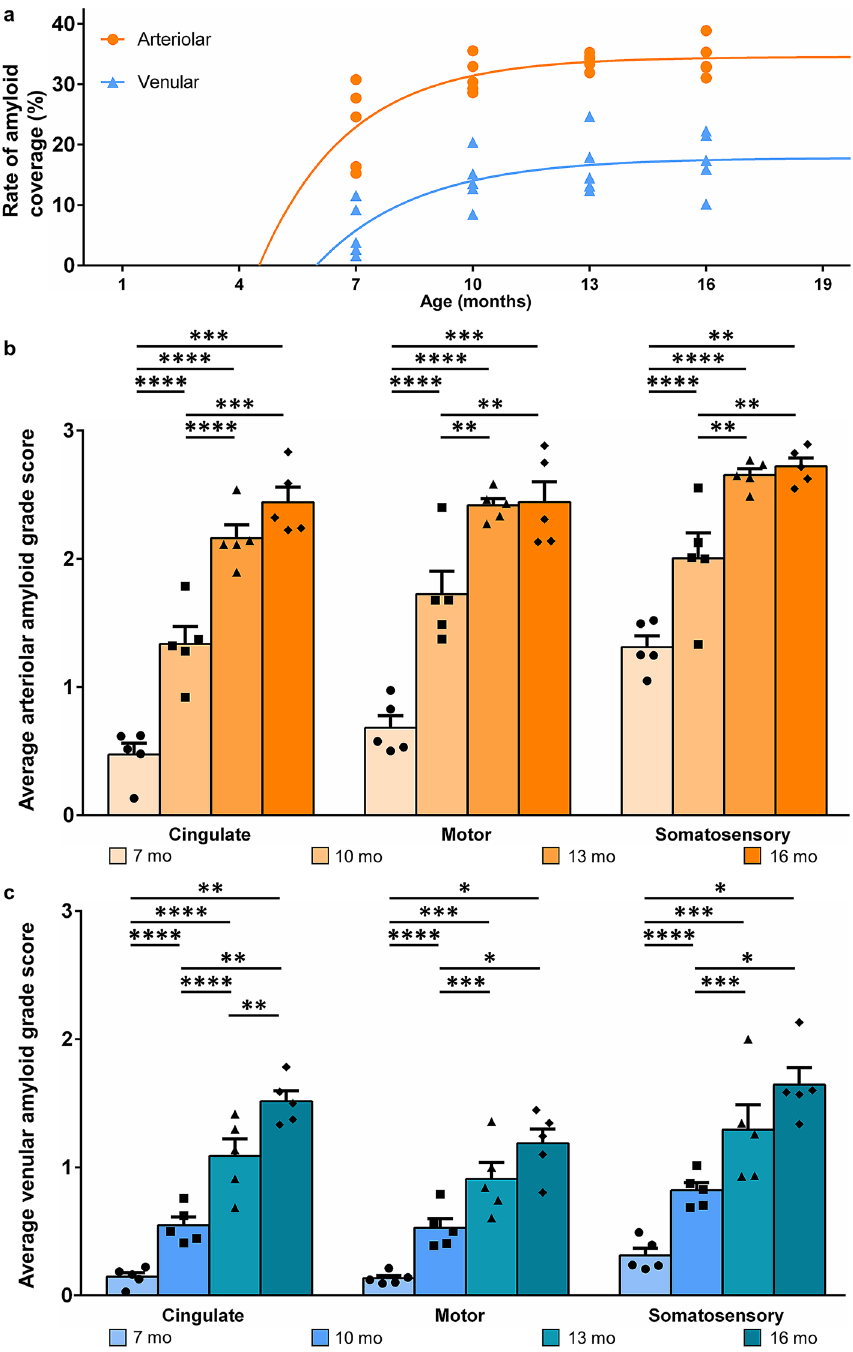
Figure 4. Rate of vascular amyloidosis and severity in AD. A one-phase association model was utilized to compare the accumulation rate of arteriolar and venular amyloid with AD progression ( a ). Arteriolar amyloid (orange, k = 0.4389) accumulated at a faster rate than venular amyloid (blue, k = 0.3860). Vascular amyloid severity was categorized based on an established grade scoring system (0–4) 36 . There was a significant age effect for arteriolar (orange) ( b ) and venular (blue) ( c ) amyloid severity score in the cingulate, motor, and somatosensory cortices (p < 0.0001). Alpha = 0.05. The values of the bar graphs were labelled as the mean of five replicates ± sem. (*p ≤ 0.05, **p ≤ 0.01, ***p ≤ 0.001, ****p <